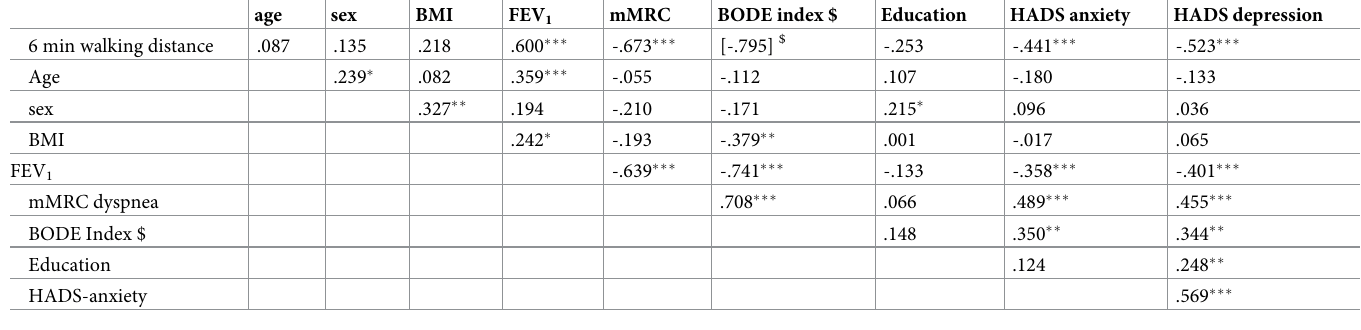
Table 2 demonstrates that no further important relationships between variables could be observed. Correlation between psychological variables and the 6-minute walk test HADS-anxiety (r = -.44, p = .0009) and HADS-depression (r = -.52, p = .00006) showed mod- erate negative correlations with the 6-minute walking test: The stronger the anxiety and depression symptoms in a patient, the shorter the walking distance within 6 minutes. Further correlations with demographic and pulmonary function variables are shown in Table 2. The hierarchical linear regression showed that FEV and the psychological variables 1 HADS-anxiety, and HADS-depression together accounted for 42% of the variance of the 6-minute walk test, with 11% of these related to the psychological variables alone ( p = .011). Table 2. Correlation matrix of 6-minute walking distance with lung function variables and HADS subscales for the 85 hospitalised COPD patients without major comorbidities. age sex BMI FEV 1 mMRC BODE index